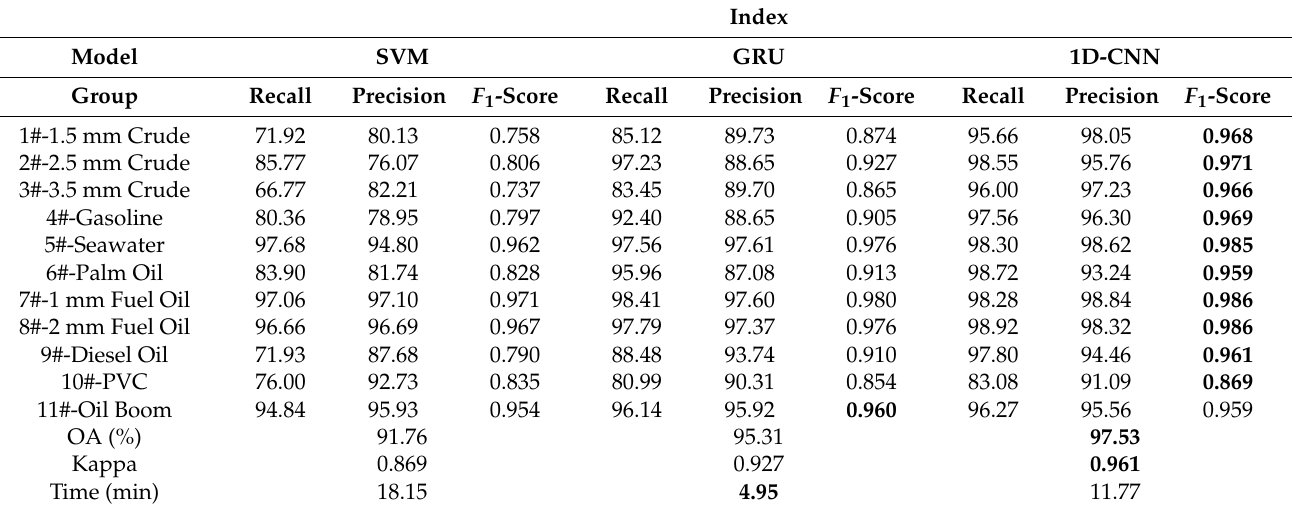
Table 6. Accuracy of the detection results at